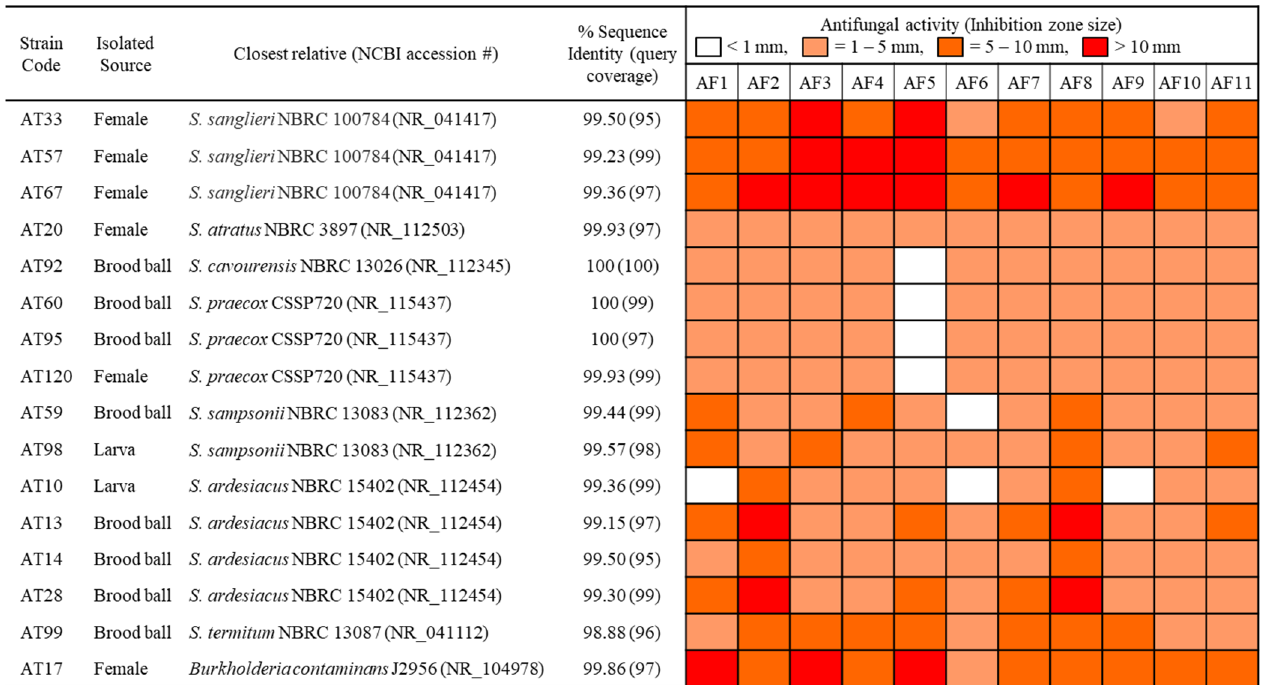
Figure 2. Identification and activity spectrum of antifungal bacterial strains isolated from the dung beetle, C. tripartitus. The bacterial isolates determined by primary antifungal screening were identified by the partial 16S rRNA gene sequences amplified using the universal primers 27F and 1492R. The antifungal activity against 11 fungi was evaluated by measuring inhibition zone size in the dual culture assays. The tested fungi were as follow: AF1: Aspergillus fumigatus , AF2: A. flavus , AF3: Beauveria bassiana , AF4: Metarhizium anisopliae , AF5: Trametes sp., AF6: Fusarium sp., AF7: Penicillium sp., AF8: Cladosporium sp., AF9: Penicillium sp., AF10: Aspergillus sp., AF11: Metarhizium sp.